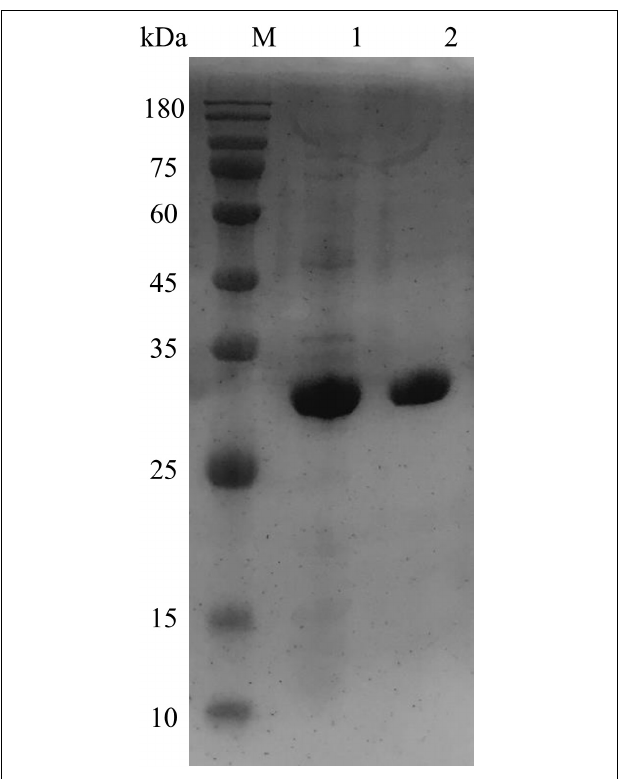
FIGURE 2 | The SDS-PAGE results of purified OhLac using Ni-NTA column. Lane 1: crude enzyme, lane 2: purified OhLac, and M: